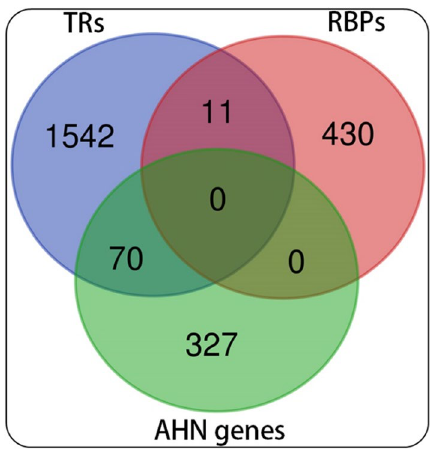
Fig. 2 Number of tran- scriptional regulators (TRs) and RNA-binding proteins (RBPs) associated with adult hippocampal neurogenesis (AHN). Genes associated with AHN (obtained from MANGO database) were compared with known TRs and RBPs retrieved from respective